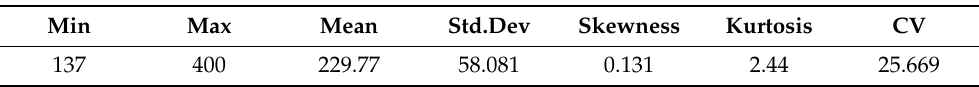
Table 2. Descriptive statistics of 20-year mean annual precipitation data of the Khorasan Razavi province